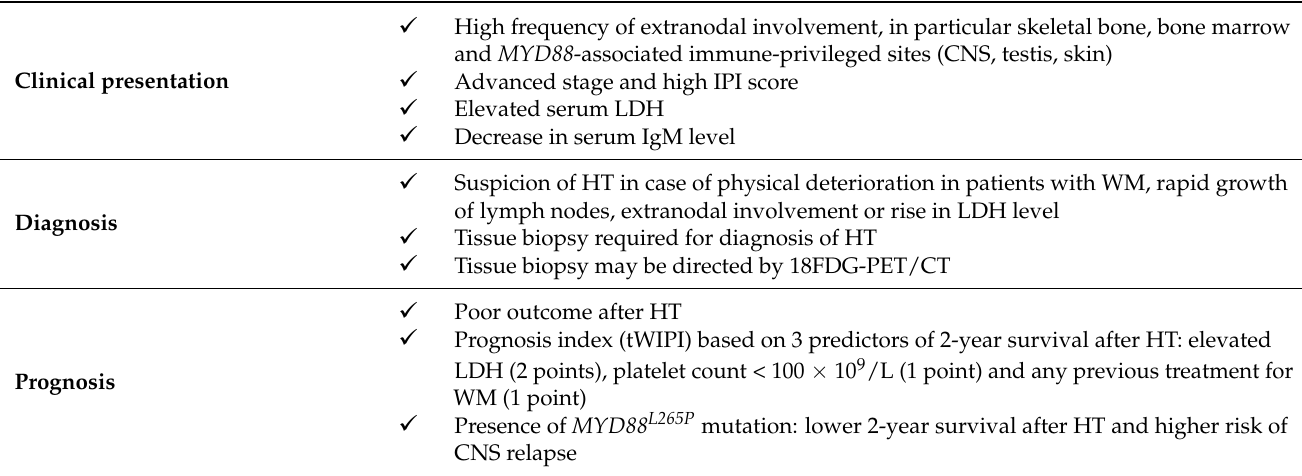
Table 2. Key points on clinical presentation, diagnosis and prognosis of HT in